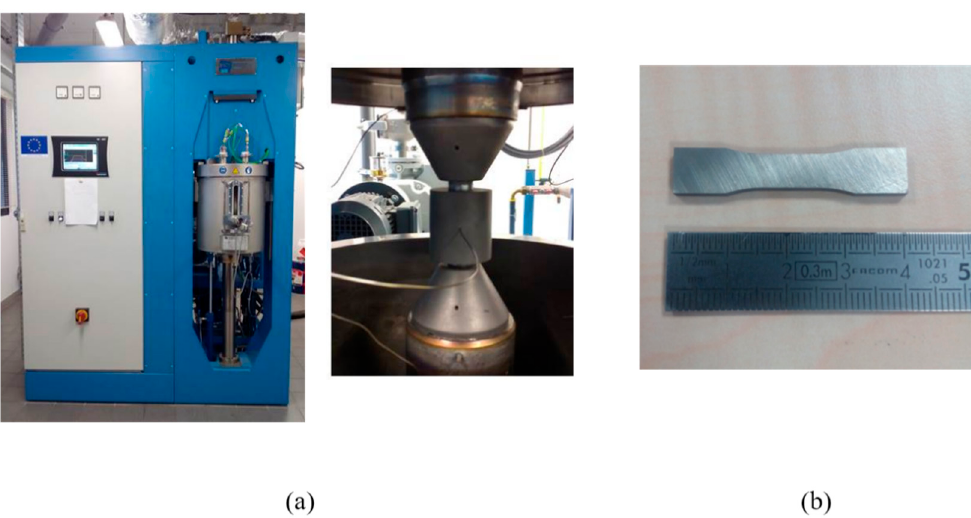
Figure 1. FCT System GmbH, HD25 SPS apparatus ( left ) and sintering set-up ( right ) ( a ). The metallic wire positioned in a hole in the die is a thermocouple used to control the sintering temperature. Tensile specimen extracted from a 50 mm sintered disc ( b ).